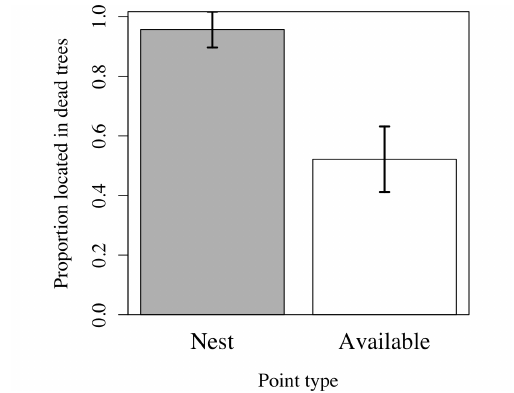
Table 2 . Summary, by nest type, of nest success rate (raw percent that fledged at least one Prothonotary Warbler, ( Protonotaria citrea ) and Brown-headed Cowbird ( Molothrus ater ) brood parasitism rate for Prothonotary Warbler nests at White River